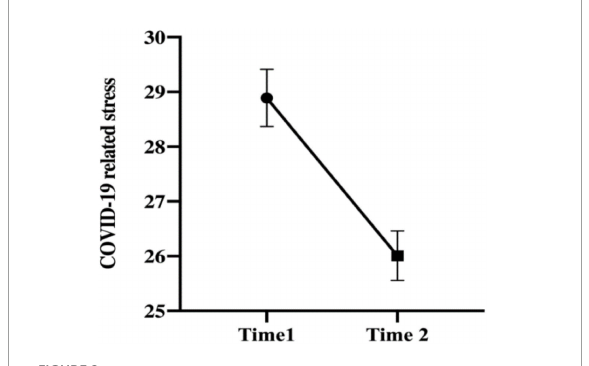
FIGURE2 Mean score of the COVID-19 related stress (IES-R) at two time points. Time 1, first wave of the outbreak; Time 2, 1 year after the first wave. Error bars indicate